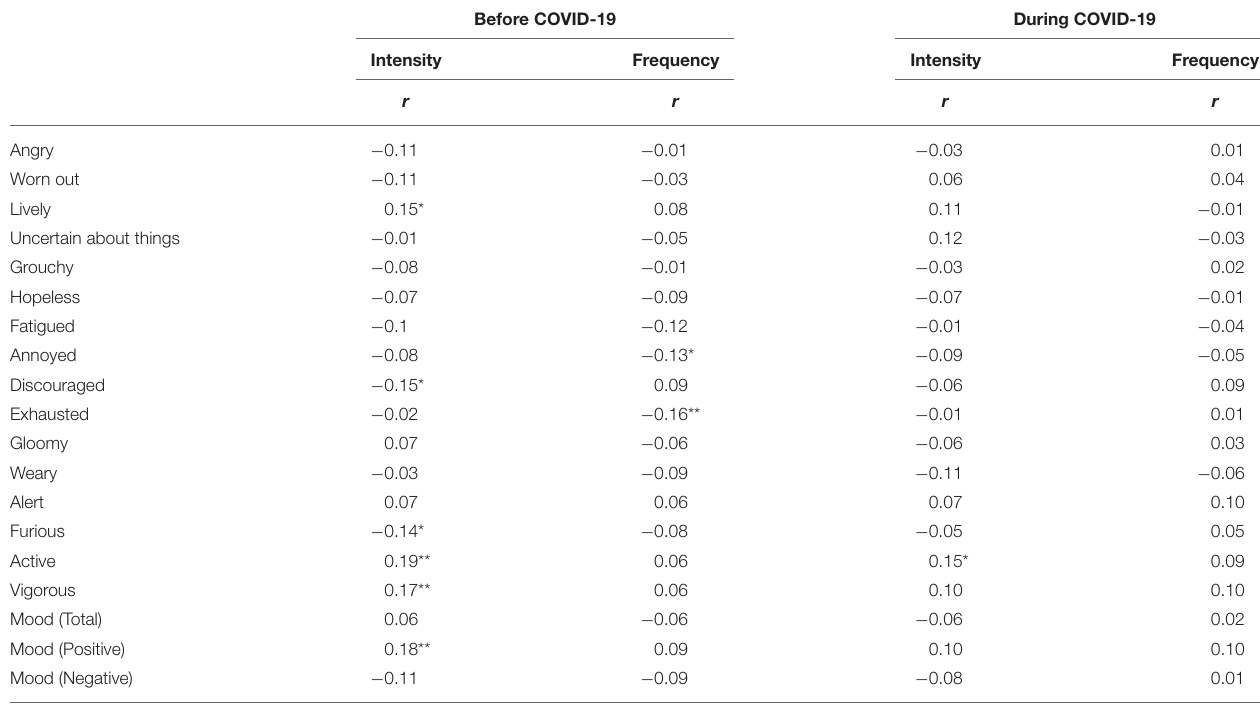
TABLE 5 | Correlation coefficients between PA indices and mood states among females. Before COVID-19 During COVID-19 Intensity Frequency